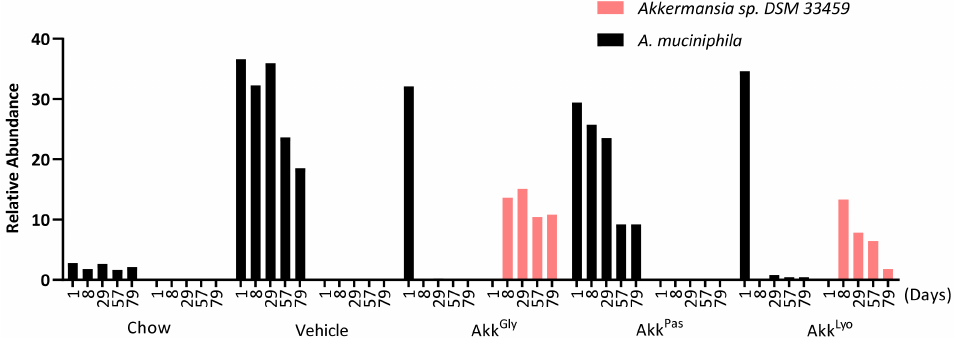
Figure 10. Engraftment of Akkermansia sp. DSM 33459 in the mice GI tract. Relative abundance of A. muciniphila and Akkermansia sp. DSM 33459 in mice fecal samples at different time